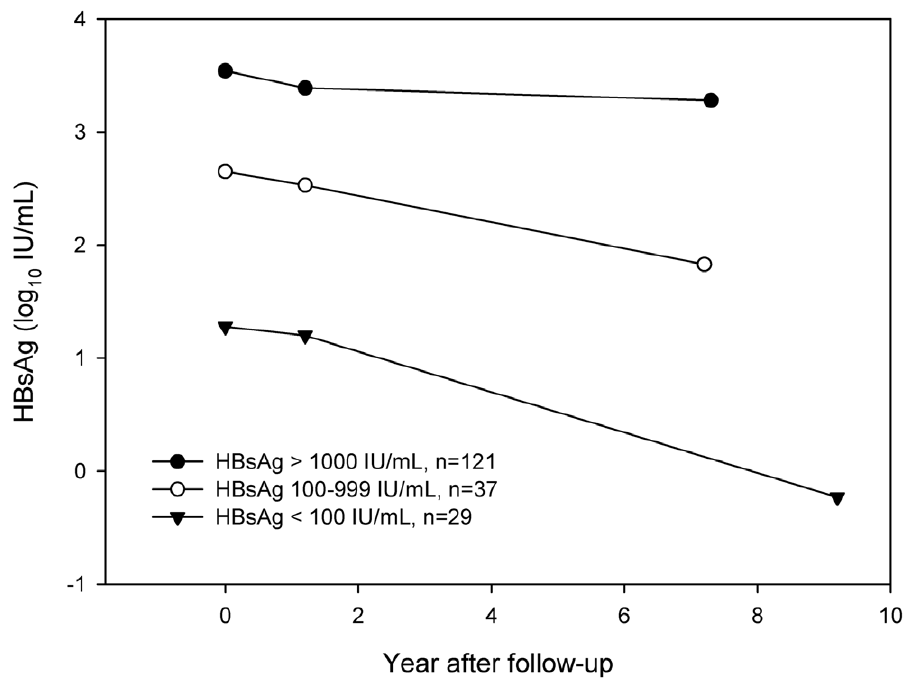
Figure 2. The dynamic change of HBsAg after stratification according to baseline HBsAg level of , 100, 100–999 and . 1000 IU/mL. The median follow-up duration was 9.2, 7.0 and 7.3 years, respectively. 165 patients (n=25, 33 and 107 in baseline HBsAg level of , 100, 100–999 and . 1000 IU/mL) with available first-year HBsAg levels were also plotted. A greater HBsAg decline was observed in patients with lower baseline HBsAg levels (1.22, 0.64, 0.42 log 10 IU/mL in HBsAg , 100, 100–999 and . 1000 IU/mL, P for